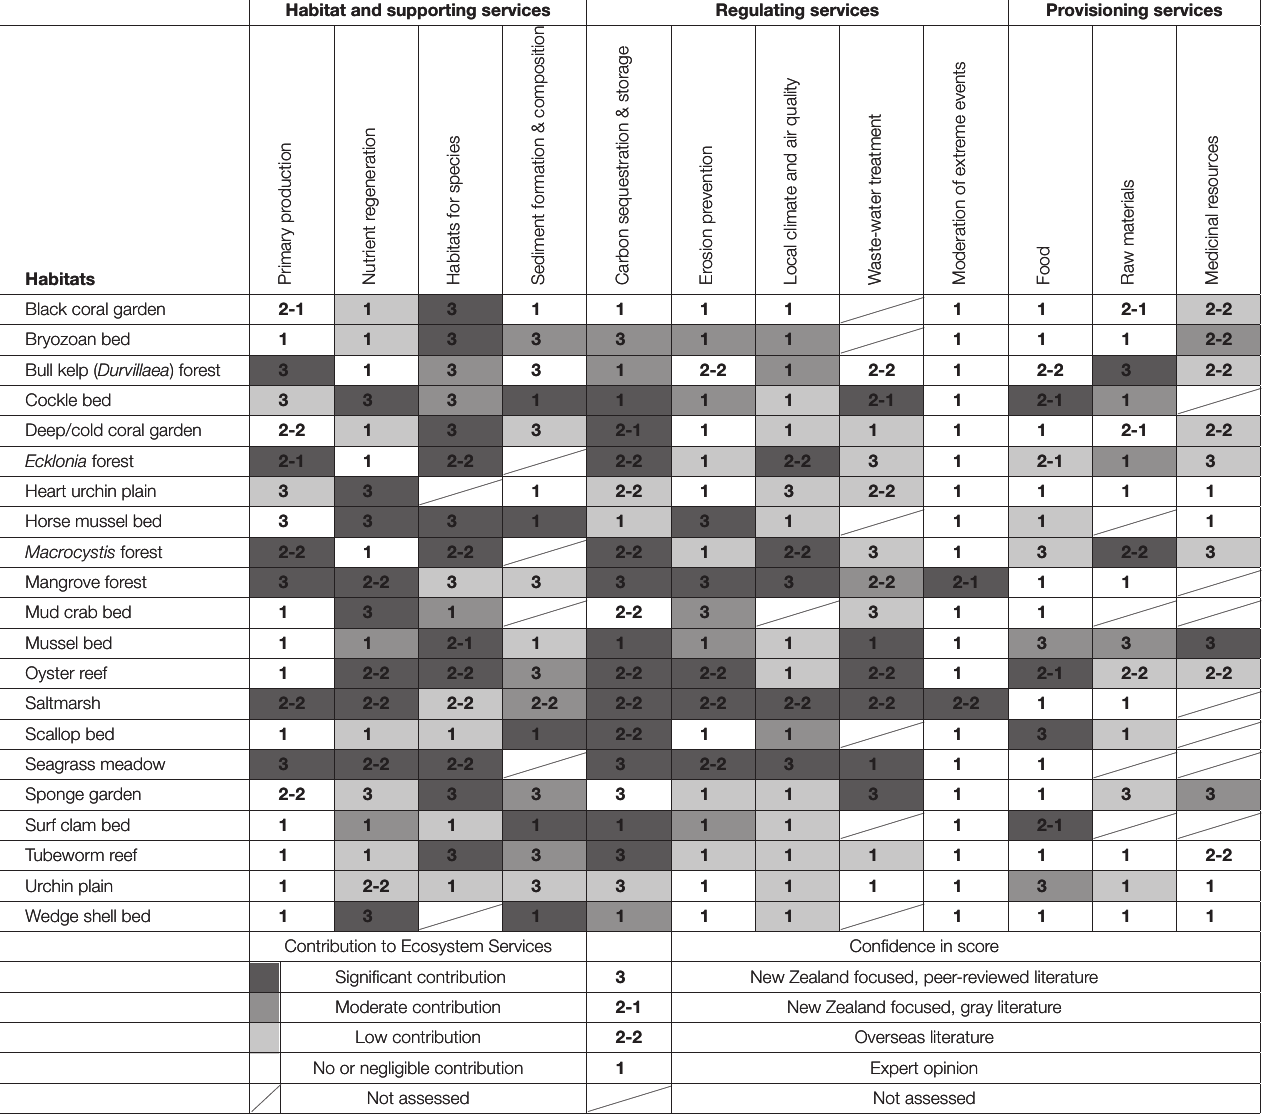
TABLE 1 | An example of an ecosystem service matrix utilizing expert information and scientific literature to evaluate the importance of marine habitats to specific